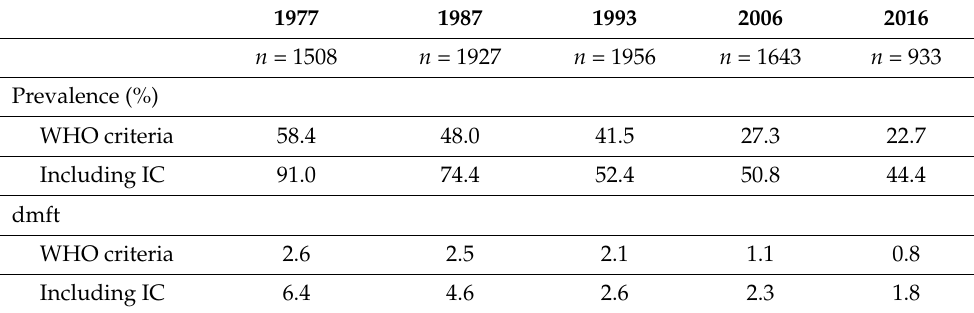
Table 1. Caries prevalence and dmft-values (both according to WHO criteria and including initial caries, IC) in preschool children in Hamburg